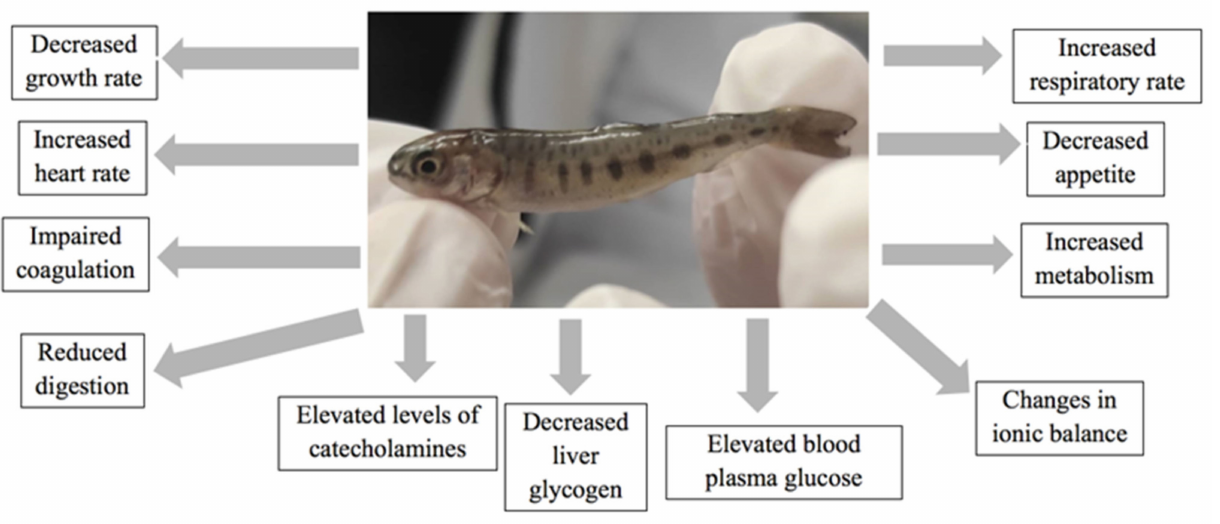
Figure 5. Schematic representation of the major climate change stressors in rainbow trout